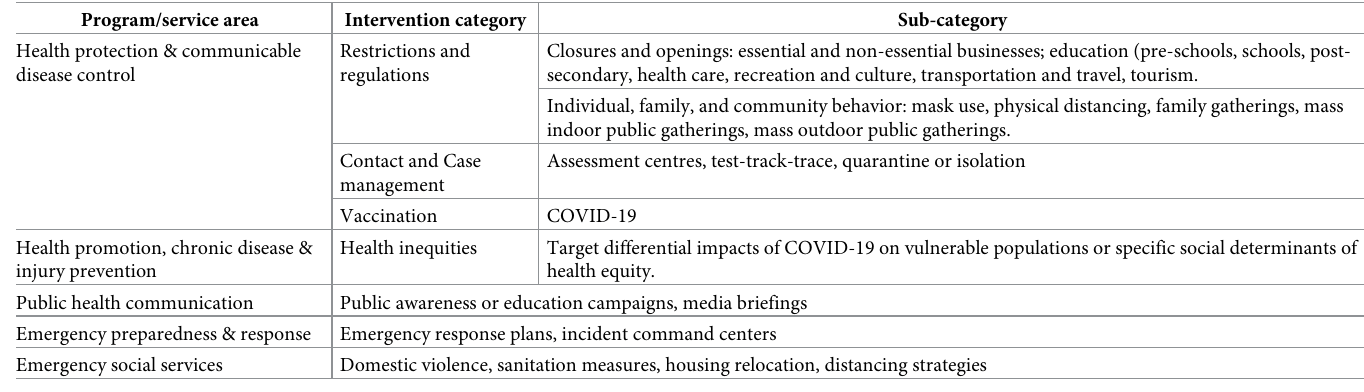
Table 2. Categories of LPHU interventions to address